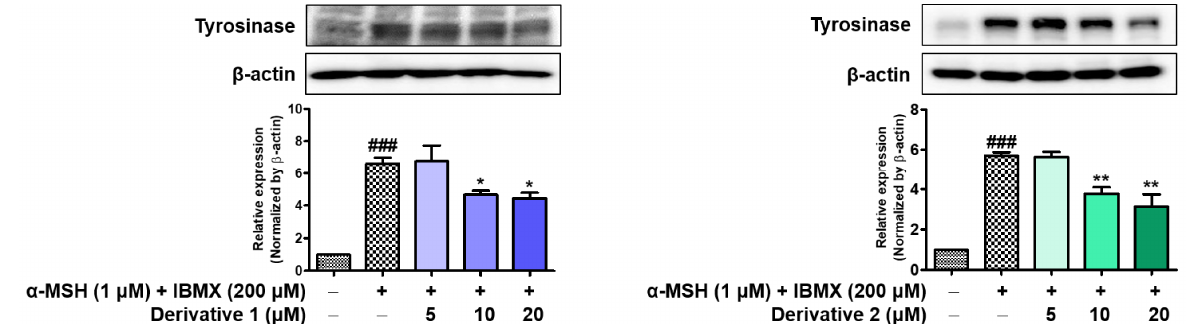
Figure 13. Effects of ( Z )-BPT derivatives 1 and 2 on tyrosinase expression. Tyrosinase expression levels were evaluated in the presence of a stimulator (1 µ M of α -MSH plus 200 µ M of IBMX) with various concentrations (5, 10, and 20 µM) of derivatives 1 and 2 in B16F10 cells. ### p < 0.001; * p < 0.05, and ** p < 0.01.